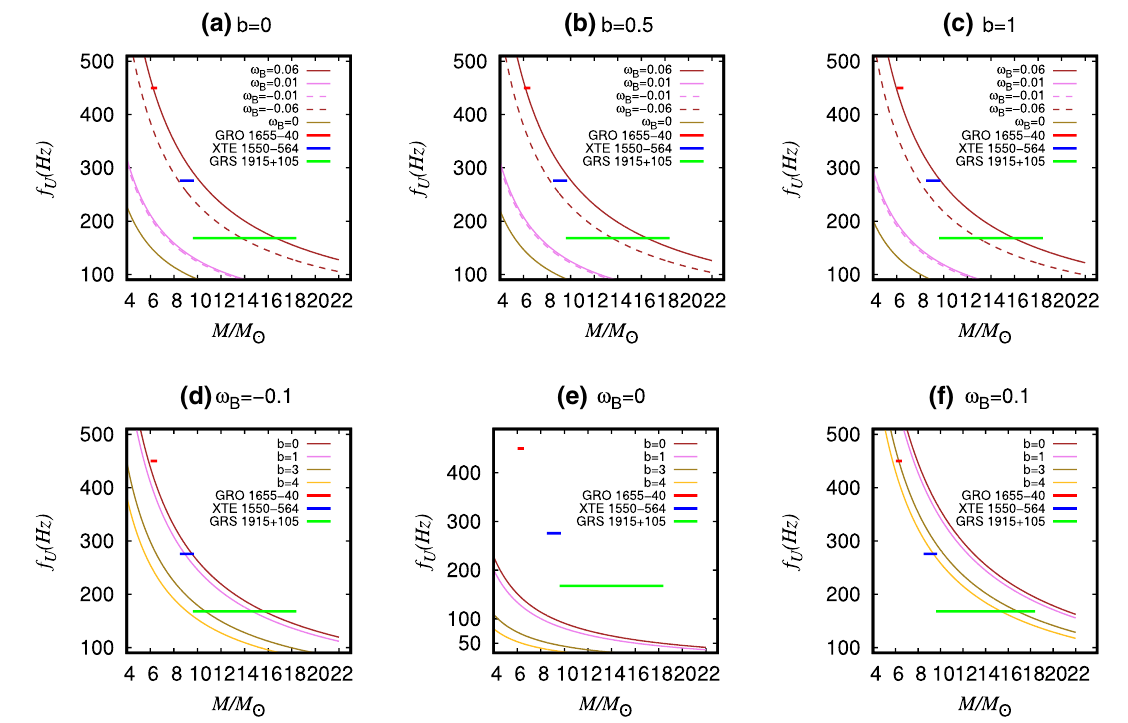
Fig. 16 The upper frequency f U (Hz) and mass M / M (cid:15) relations for different parameters b and ω B with the case of ν θ : ν x = 3 : 2. And GRO 1655-40, XTE 1550-564 and GRS 1915+105 are respectively denoted by red, blue and green horizontal